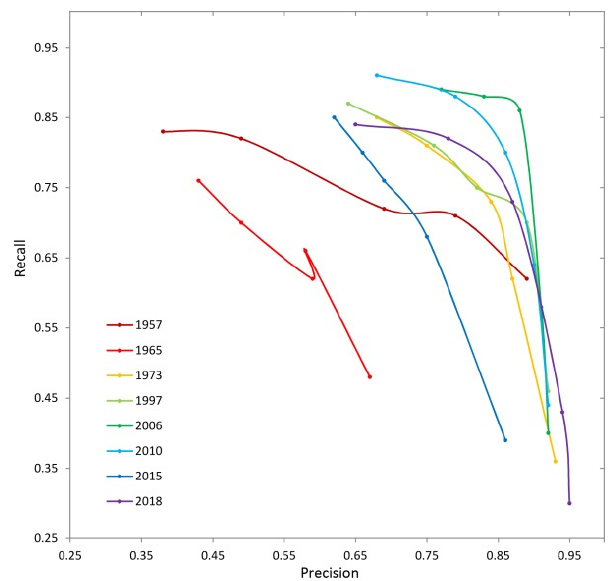
Figure 6. The precision–recall curves covering segmentation for five spatial parameter (SP) candidates. A curve located in the upper-right corner indicates high segmentation quality (Zhang et al., 2015).